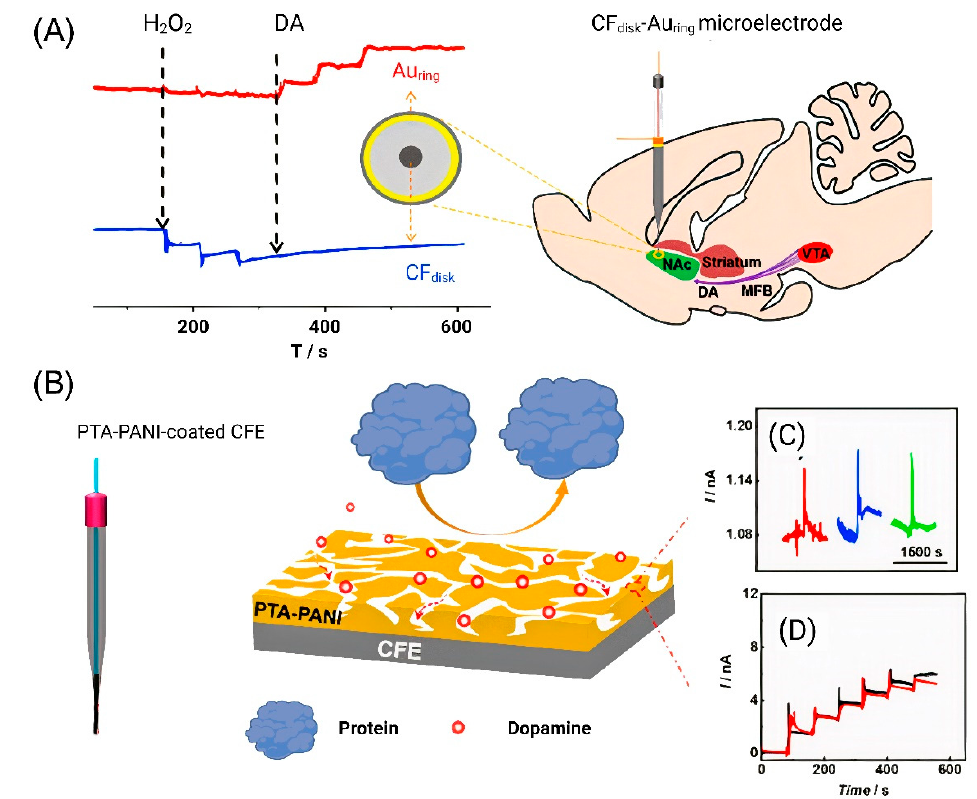
Figure 3. DA detection using modified CFE. ( A ) Simultaneous detection of DA and hydrogen peroxide in NAc. Reproduced from [65], copyright 2019 Elsevier. ( B ) Illustration of the structure of the PTA − PANI nanoporous membrane and the interface between PTA − PANI-coated CFE. ( C ) Amperometric response recorded with PTA − PANI-coated CFE implanted in the rat NAc by multiple stimulating MFB (each color corresponds to one independent stimulation). ( D ) Pre- (black curve) and post-calibration (red curve) curves obtained with PTA − PANI-coated CFE. Reproduced from [66], copyright 2019 American Chemical Society.